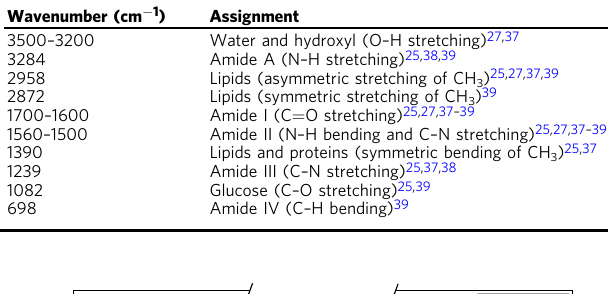
Fig. 3 Cross-validated prediction results for the human class using the human – animal PLSDA model with six latent variables from blood samples. Each symbol corresponds to an individual ATR FT-IR spectrum with 10 spectra per donor. Human blood spectra are shown as red diamonds and animal blood spectra are shown as green squares. The red dotted line is the threshold for classi fi cation of spectra in the human class. Only one spectrum from a human sample is misclassi